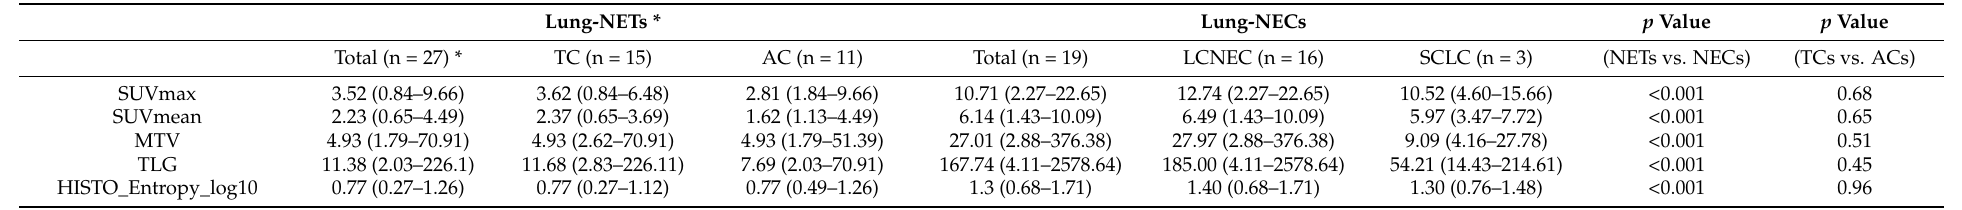
Table 2. Comparison between conventional and volumetric PET parameters and HISTO_Entropy_log10 in neuroendocrine carcinomas (NECs) versus neuroendocrine tumors (NETs) and in typical carcinoid (TC) versus atypical carcinoid